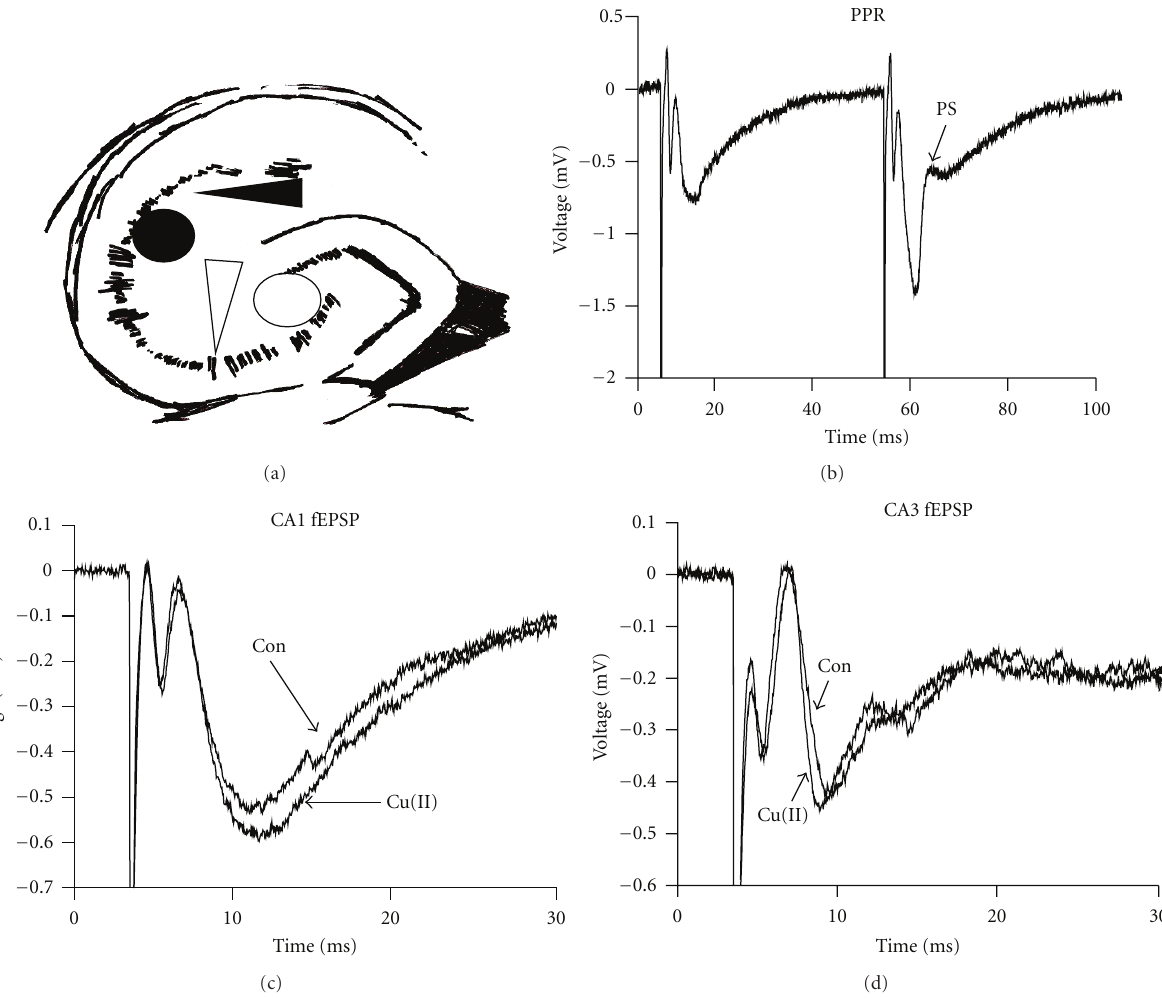
Figure 1: Electrophysiological recording in the mouse hippocampal slice. (a) In the CA1 region, the stimulating electrode (black circle) and the recording electrode (black arrow) were placed in the stratum radiatum. In the CA3 region, the mossy fibers were stimulated (white circle), and recording was done in the stratum lucidum (white arrow). (b) A representative trace from one brain slice showing how a paired- pulse test appeared at the stimulus intensity chosen for recording. (c) and (d) The average of the slopes of the fEPSPs taken 30 seconds before the tetanus was not changed by copper in either the CA1 or CA3 regions ( n = 8, data not shown). Representative traces from an interleaved experiment are